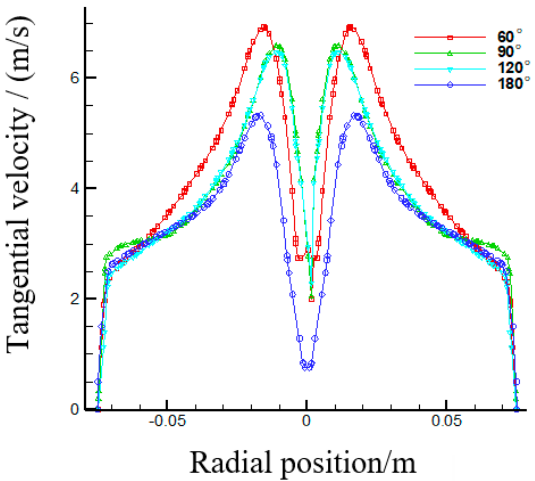
Figure 10. Tangential velocity distribution of different cone angle cyclone.